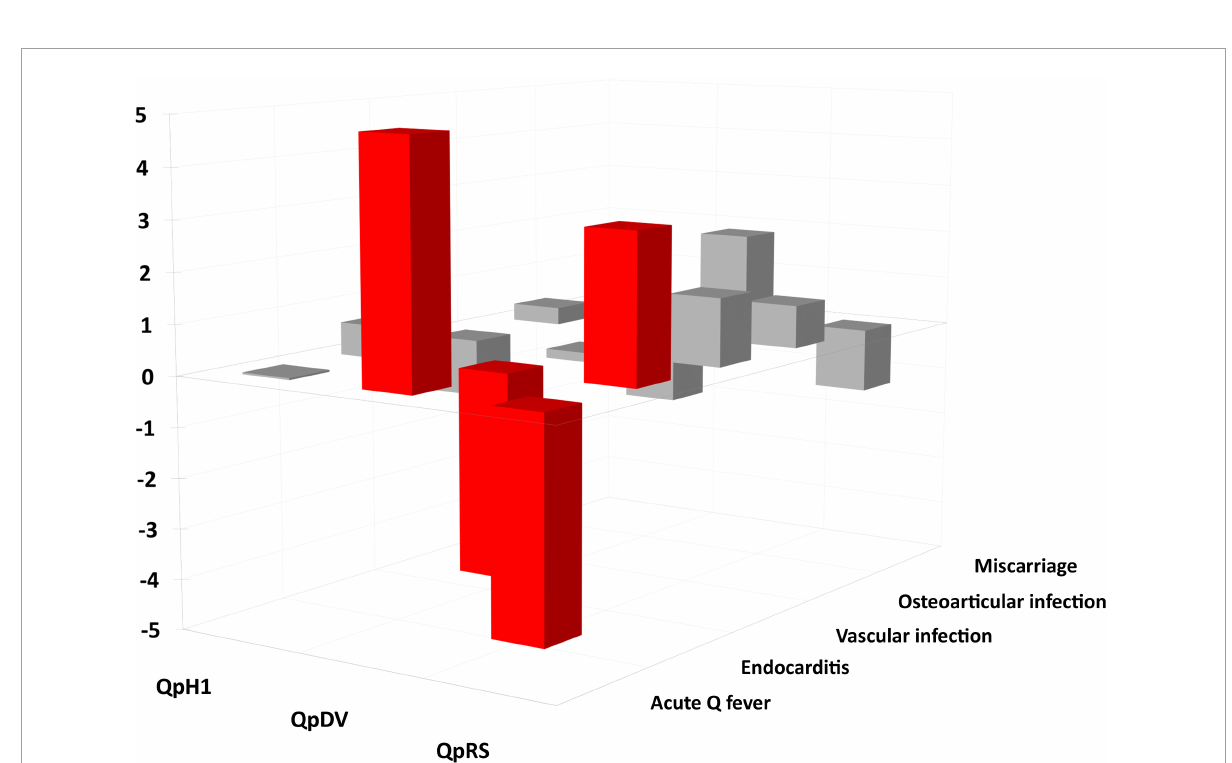
FIGURE8 Plasmids and clinics residual analysis. Red: significant difference ( p -value <